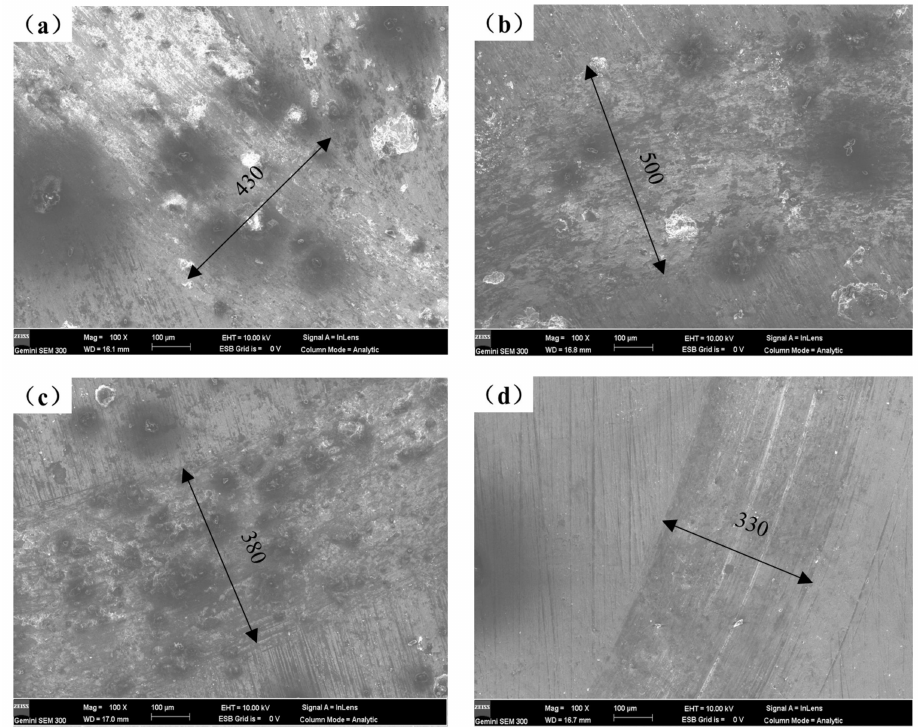
Figure 8. Worn surface morphologies of different coatings: ( a ) AS, ( b ) AS1Y, ( c ) AS1.5Y, and ( d )